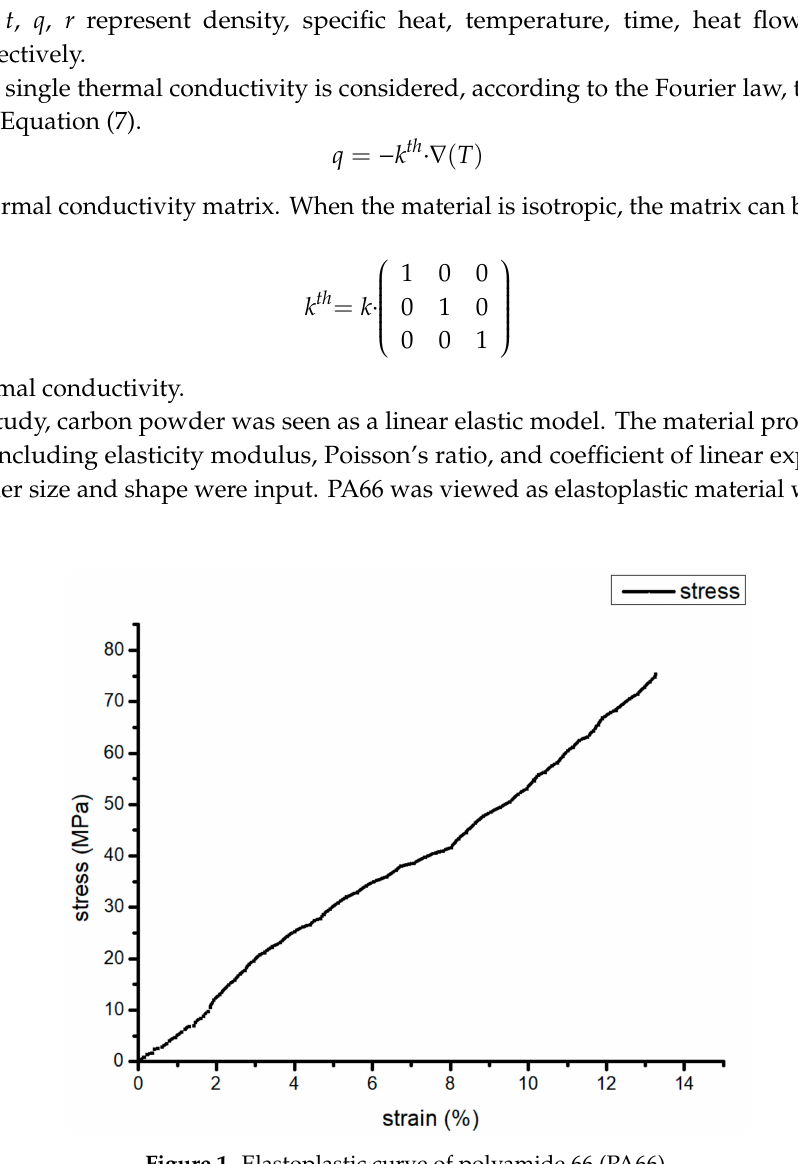
Figure 1. Elastoplastic curve of polyamide 66